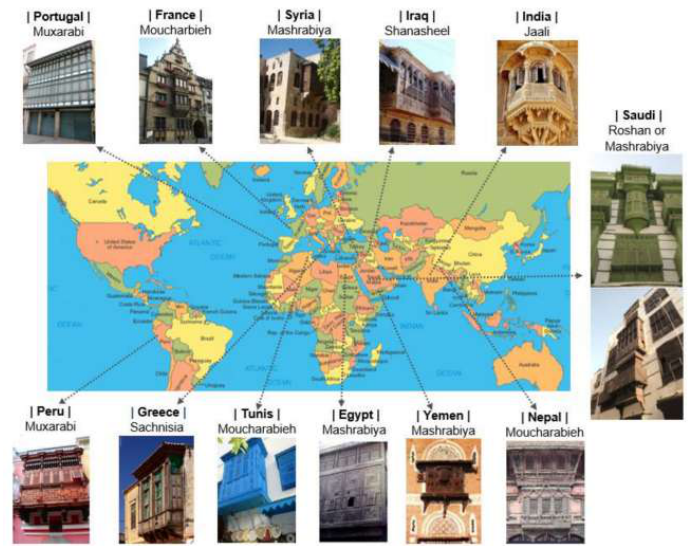
Figure 2. Traditional Mashrabiya around the world and its local